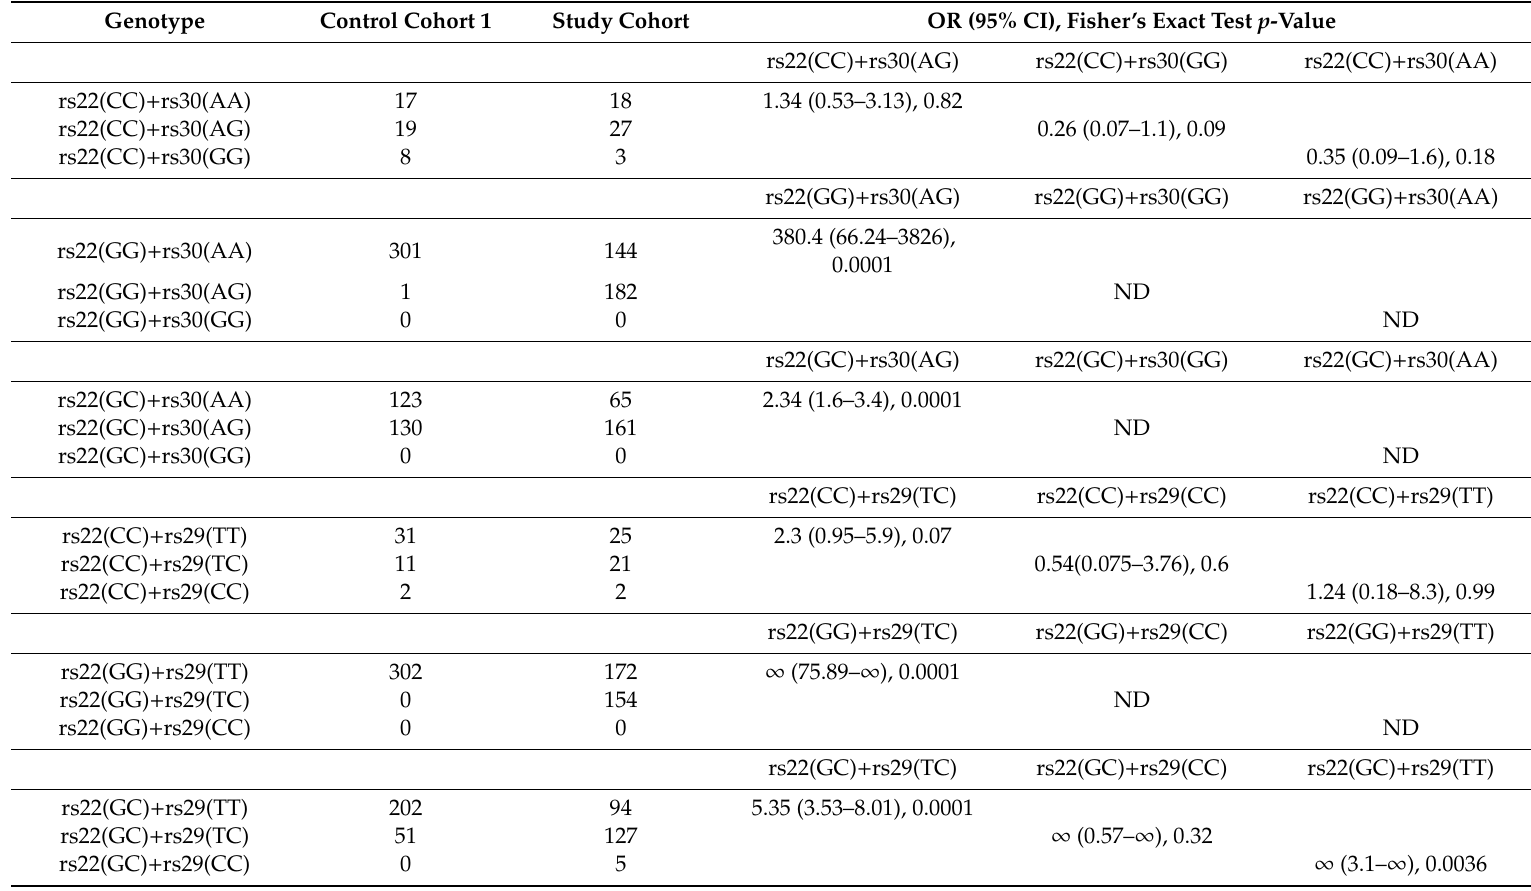
Table 2. Association of TP53 haplotypes with